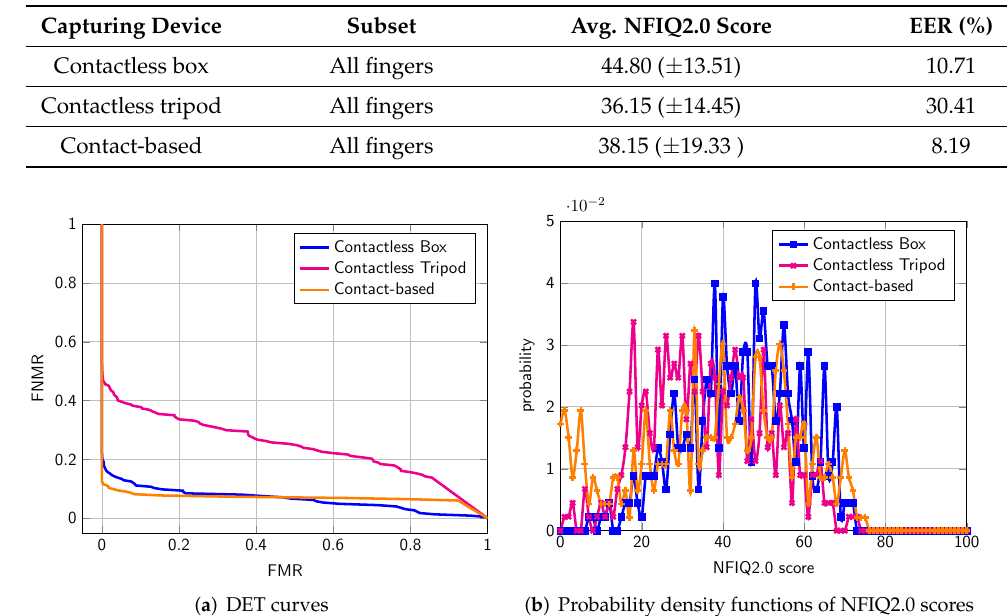
Figure 8. NFIQ2.0 score distribution and biometric performance obtained from single finger comparisons.